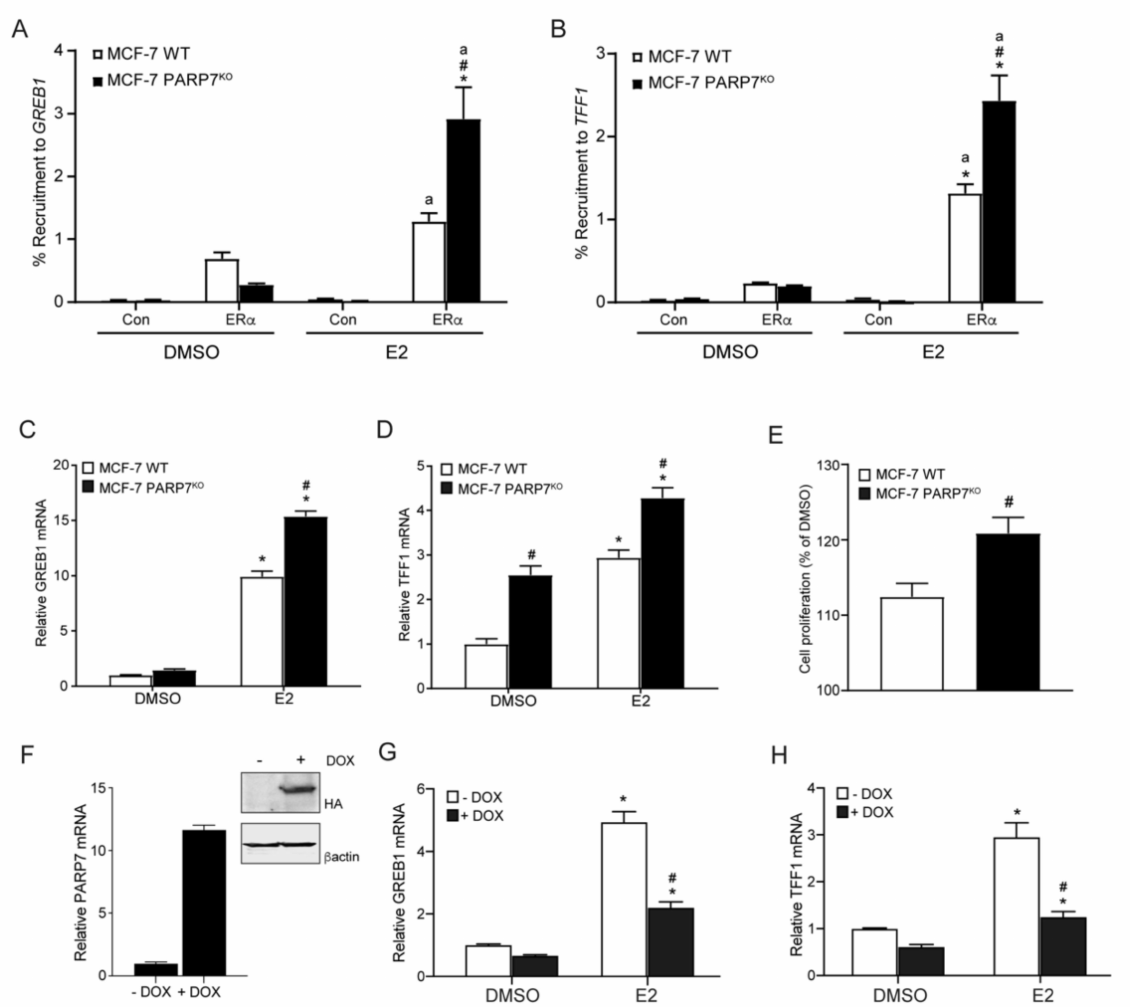
Figure 4. MCF-7 PARP7 KO cells display increased ER α activity. Recruitment of ER α to the regulatory regions of ( A ) GREB1 and ( B ) TFF1 was increased in MCF-7 PARP7 KO cells compared with MCF-7 wildtype cells. Cells were treated with